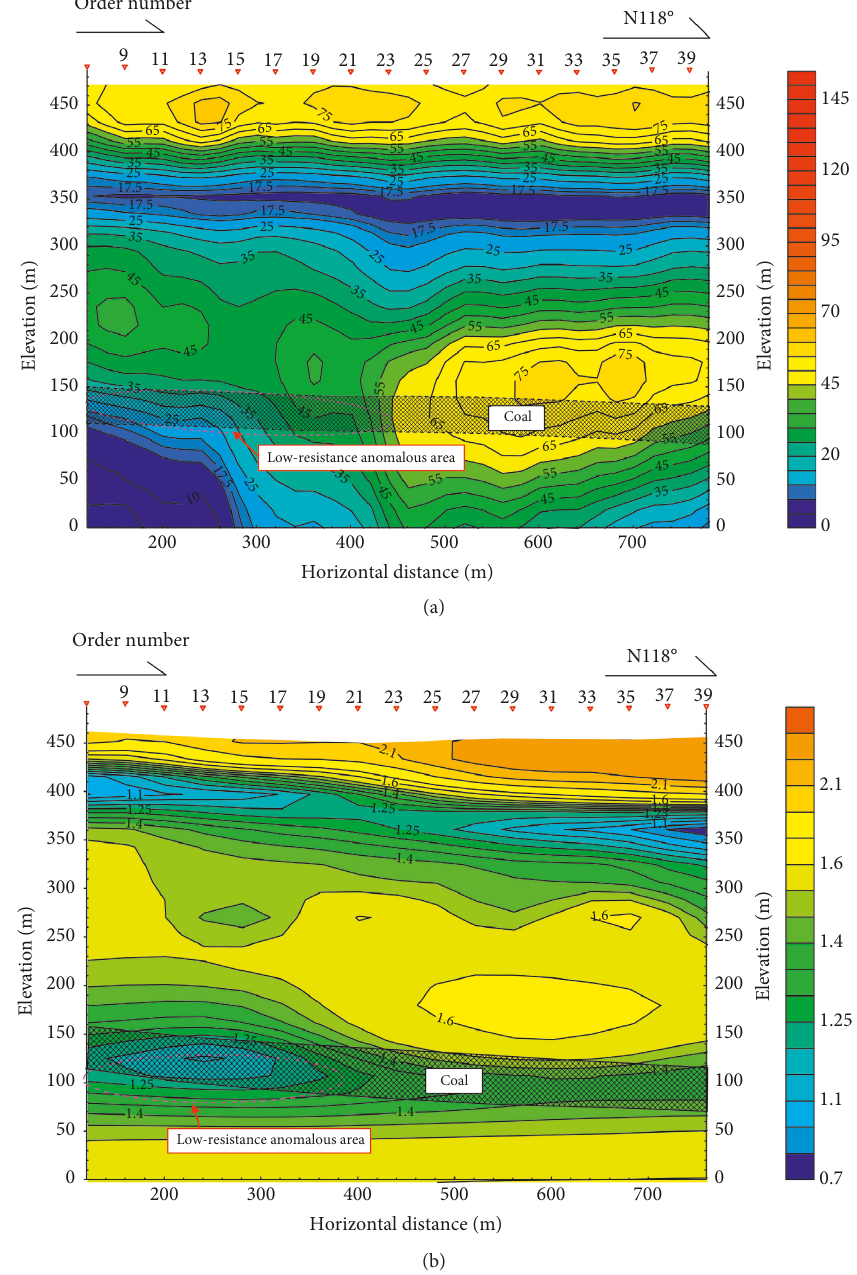
Figure 14: Resistivity sections obtained by different methods. (a) Inversion of the resistivity profile from line 31 of the TEM method. (b) Inversion of resistivity profile from line 31 of CSAMT